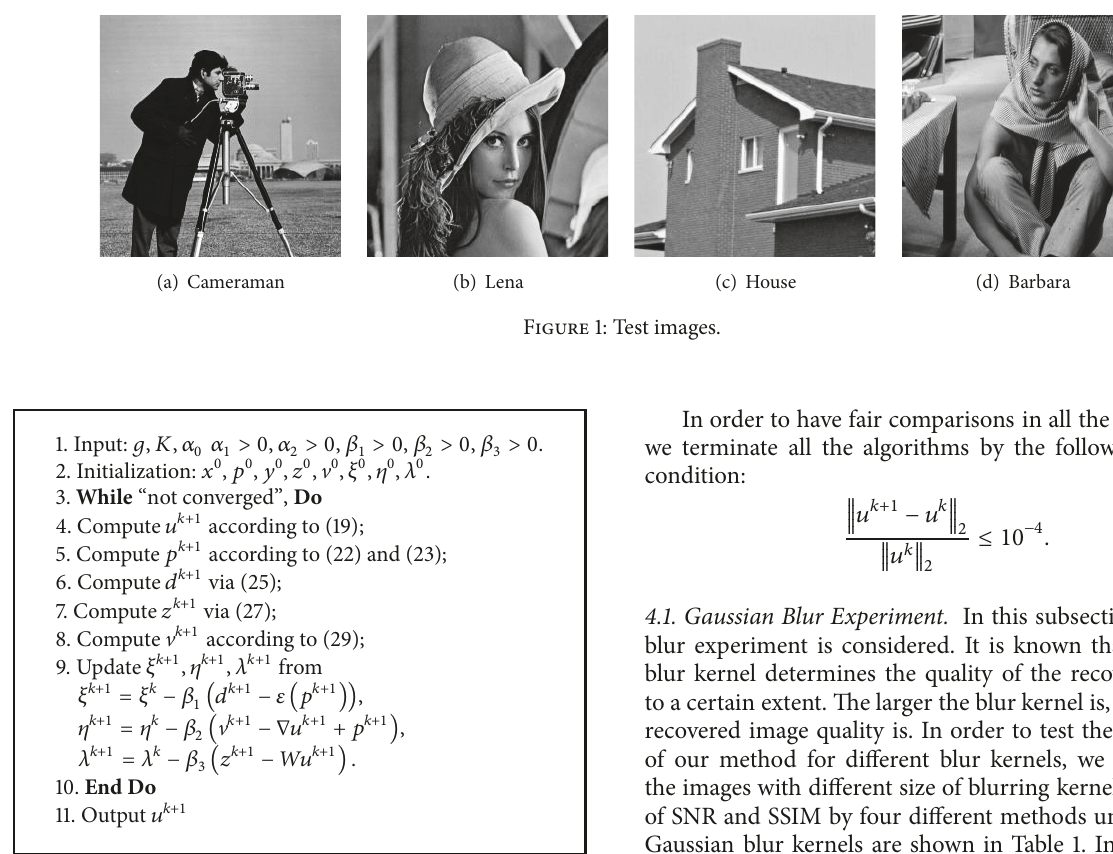
Algorithm 1: ADMM for the TGVframe